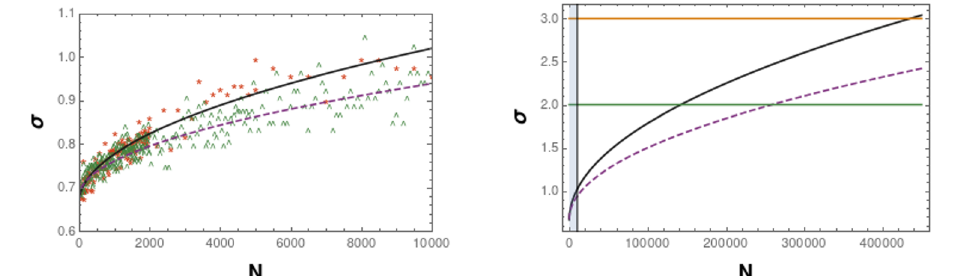
Figure 6 . Number of Higgs to four lepton events N required to distinguish the SM from the SUSY model benchmarks at a given significance σ . The left figure shows the curve fitted to the average statistical significance of pseudo-experiments featuring a given number of events. The dashed violet line (fit to the green carets) is the stop scenario and the solid black line (fit to the red asterisks) is the F-stop scenario. The right figure shows an extrapolation of this data with lines at 2 and 3 σ significance. The thin blue band on the left is the reach of the